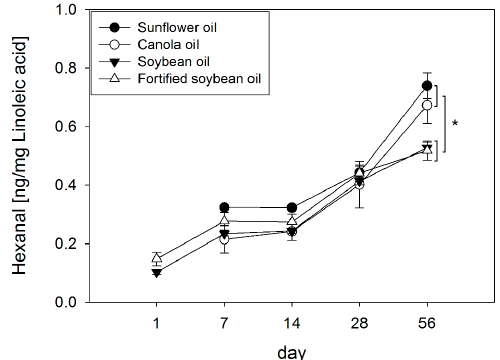
Figure 4. Changes of the hexanal content normalized to the linoleic acid concentration of each oil type (sunflower, canola, soybean oil, fortified soybean oil) after storage at 22 °C in a 12 h light/dark cycle for 56 days. Data are represented as mean ± SD ( n = 3–4). Statistically significant differences between the different oil types on day 56 were analyzed using one-way ANOVA ( p ≤ 0.001) followed by Holm-Sidak post hoc test (* p < 0.05). Hexanal concentrations in sunflower and canola oil were below the limit of quantification on day 1.